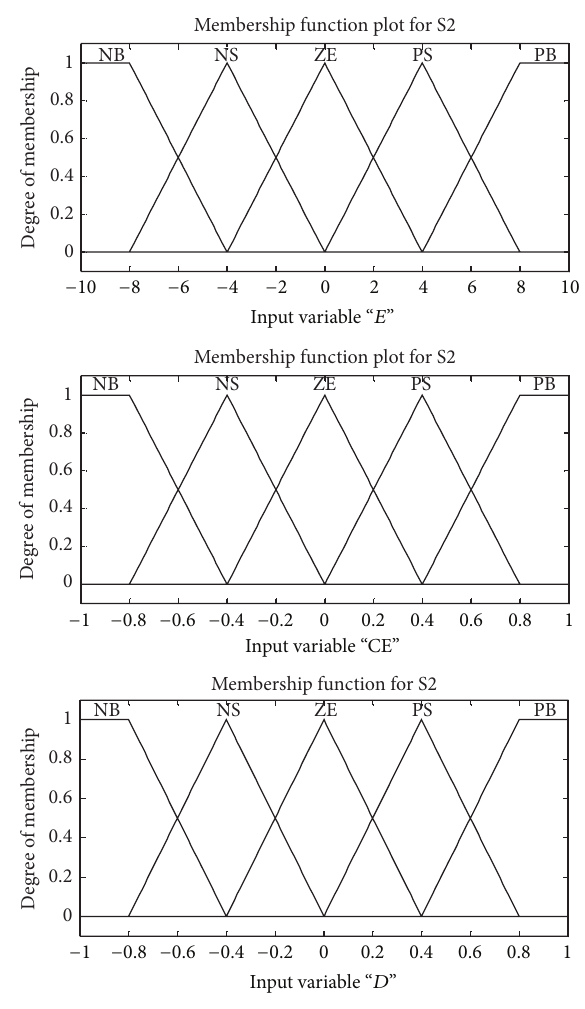
Figure 10: The membership functions of 𝐸 , CE, and 𝐷 for